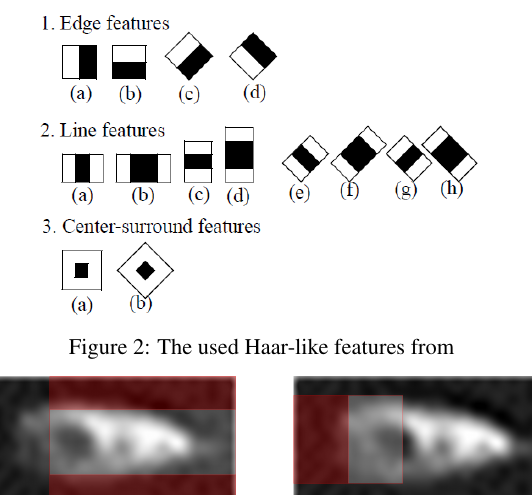
Figure 3: The first Haar-like features of the